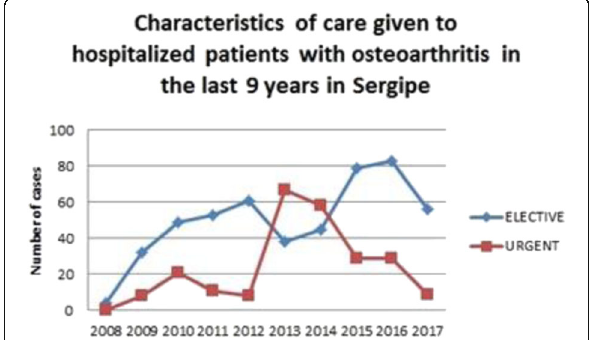
Fig. 1 (abstract P098). Characteristics of care given to hospitalized patients with osteoarthritis in the last 9 years in